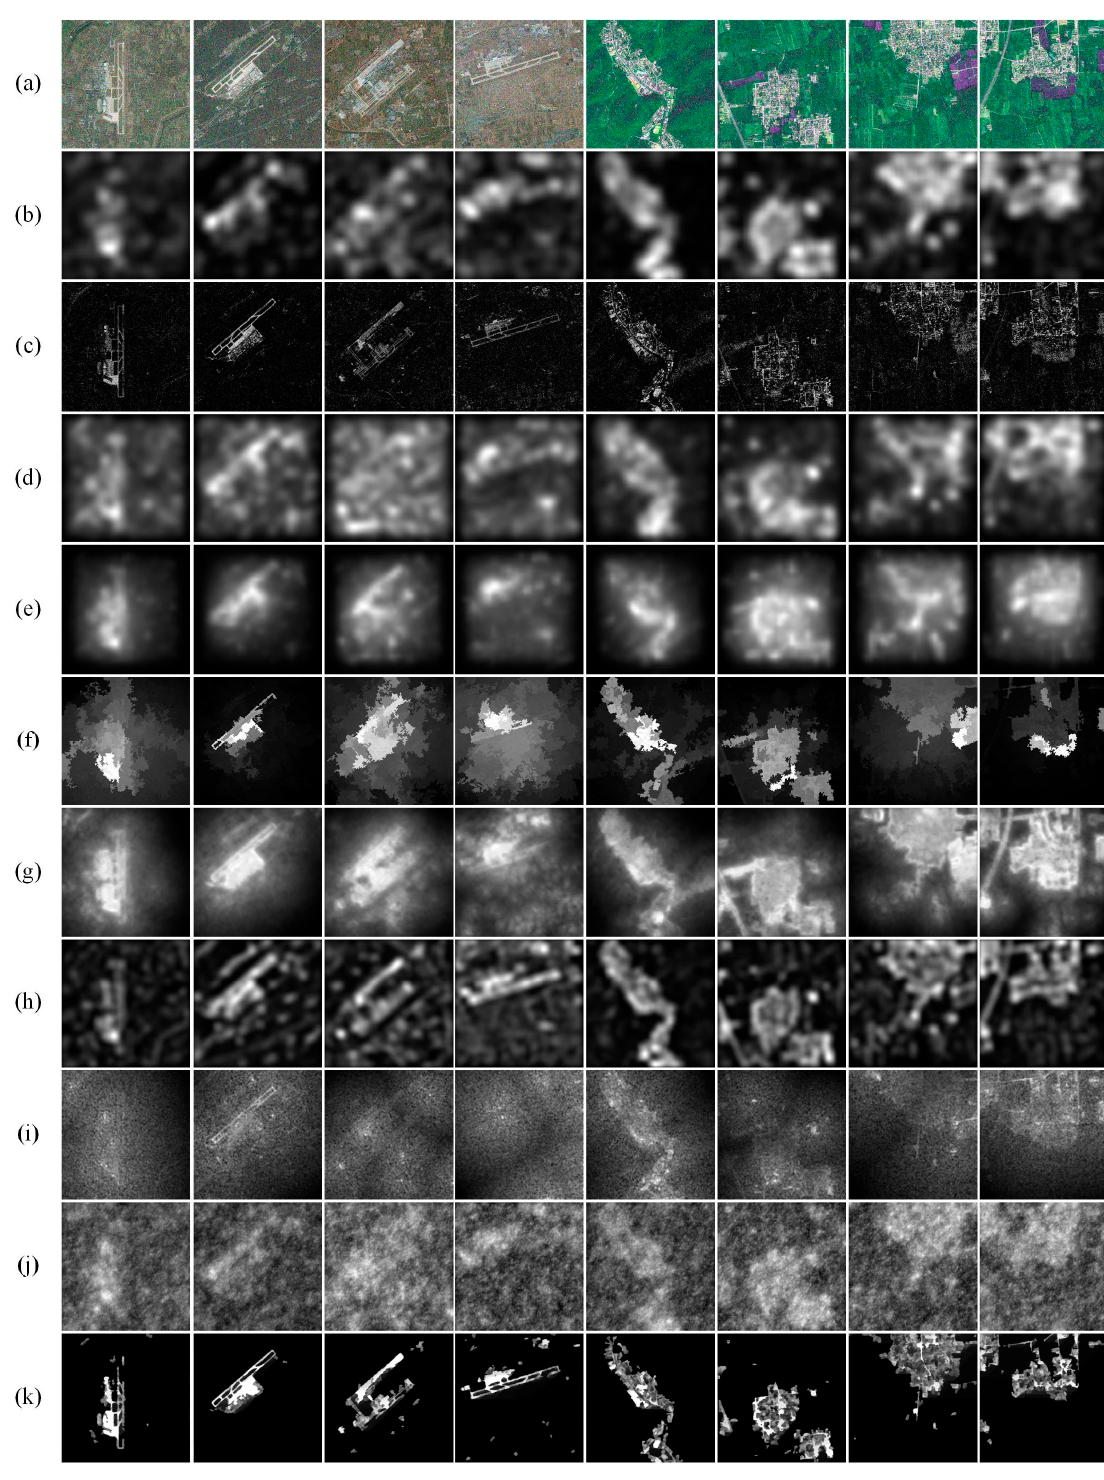
Figure 12. Comparison of saliency maps for images polluted by Gaussian noise (Standard Variance = 0.05) (first four images are from the SPOT5 satellite and last four are from Google Earth): ( a ) remote sensing image; ( b ) SR; ( c ) FT; ( d ) ITTI; ( e ) GBVS; ( f ) H; ( g ) CA; ( h ) FDA; ( i ) WT; ( j ) MFF; and ( k ) LI.